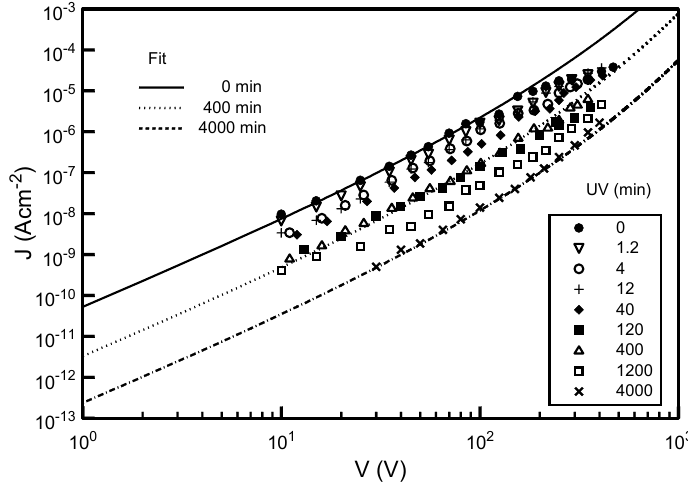
Figure 2. SCLC J ( V ) data recorded for a series of DEH MDP films that have been subjected to the UV exposure periods indicated. The solid lines show the optimised fit of Equation (3) for selected UV exposures: 400 min, θ = 0.15; 4000 min, θ =